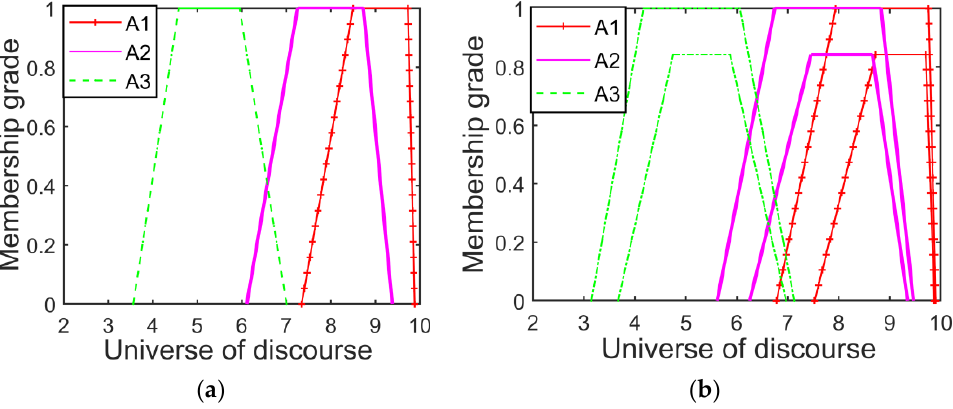
Figure 6. Comparison results of the evaluation method based on T1 FSs and the method of this study: ( a ) Overall ratings obtained by the evaluation method based on T1 FSs; ( b ) Overall ratings obtained by the method of this study.